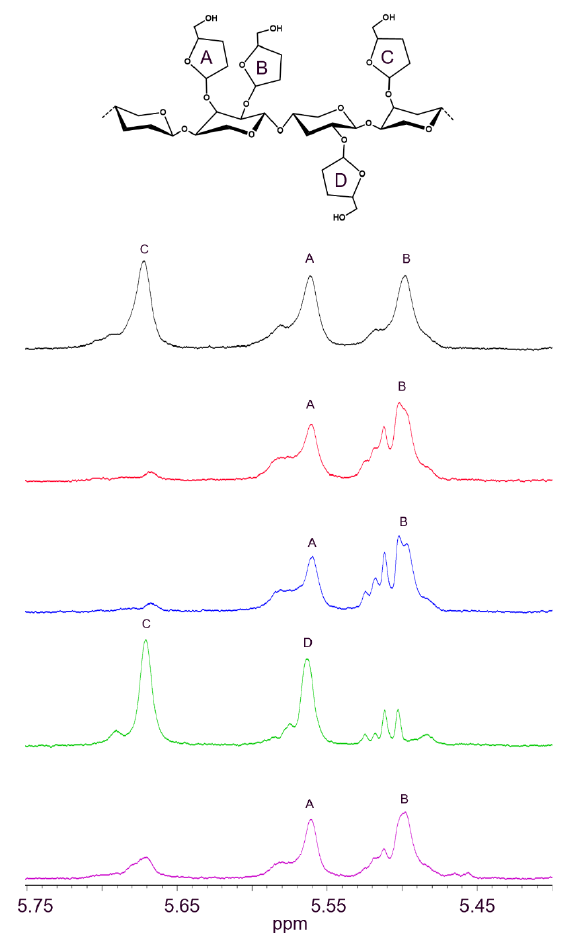
Figure 3. 1 H-NMR spectra of arabinoxylan (AX) incubated without enzyme (black) and with Mg ABF51 (red), Po ABF62 (blue), Hi ABF43_36a (green), and Tp ABF43_36b (purple). The 50 μg mL −1 enzyme was incubated with 1 mg mL −1 AX for 1 h. A: α -(1 → 3)-Ara from dXyl; B: α -(1 → 2)-Ara from dXyl; C: α -(1 → 3)-Ara from mXyl; D: α -(1 → 2)-Ara from mXyl. Chemical shifts of the 1 H-protons belonging to the different arabinosyls present in AX were identified by comparison with previous research [7,11]. Reaction conditions are displayed in Section 4.2.2, exp. # 1.